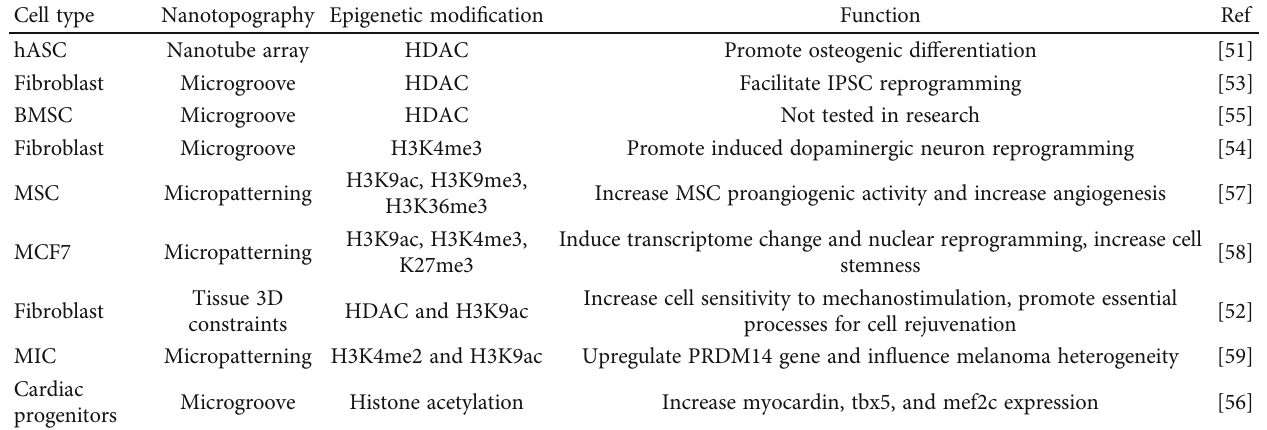
Table 4: Examples of nanotopography-regulated histone modi fi cations. Cell type Nanotopography Epigenetic modi fi